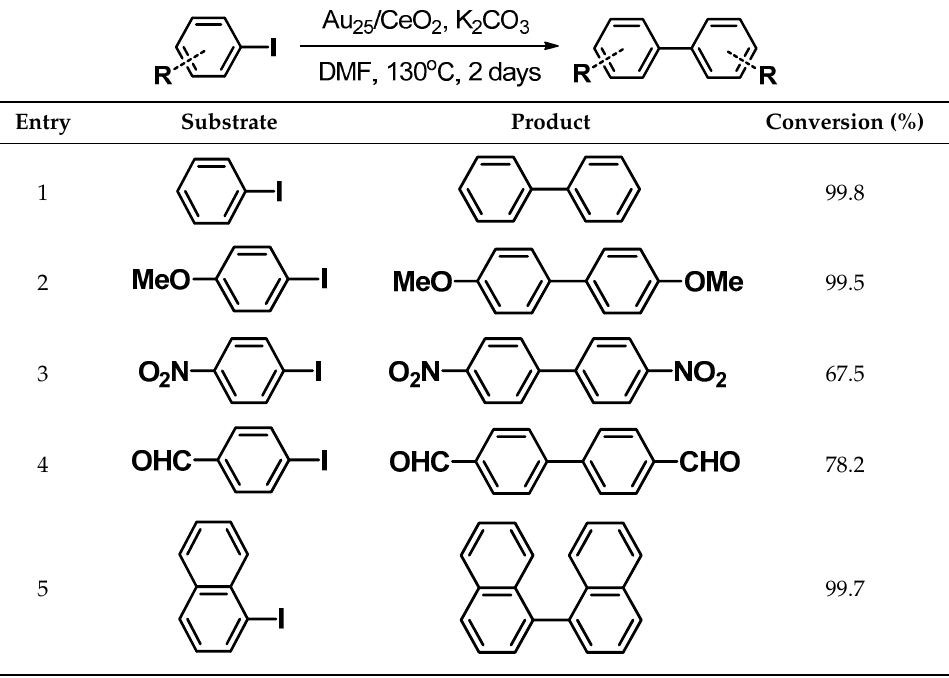
Table 1. The catalytic results over the Au 25 (PET) 18 /CeO 2 catalysts in Ullmann homo-coupling.